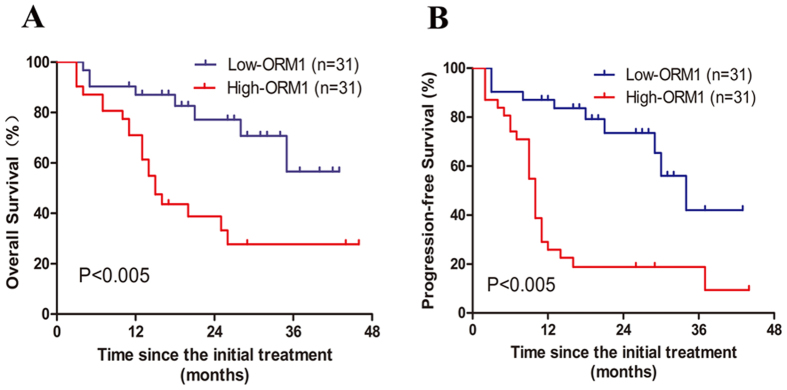
Survival of low-ORM1 group and high-ORM1 group.(A) High levels of ORM1 in serum were associated with inferior overall survival (P = 0.0012). (B) High levels of ORM1 in serum were associated with inferior progression-free survival (P < 0.0001).